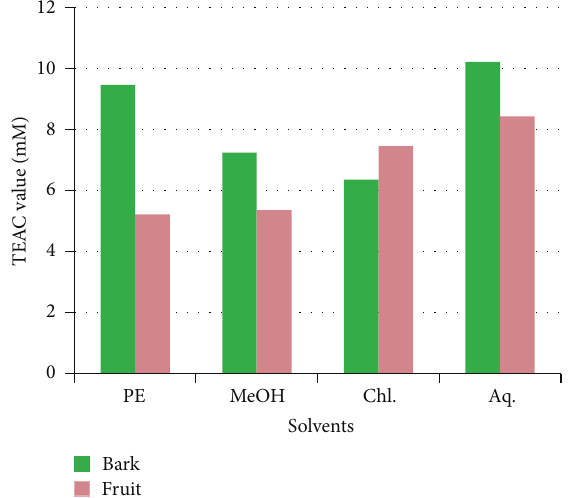
Figure 17: ABTS activity of different parts of C. ambrosioides .